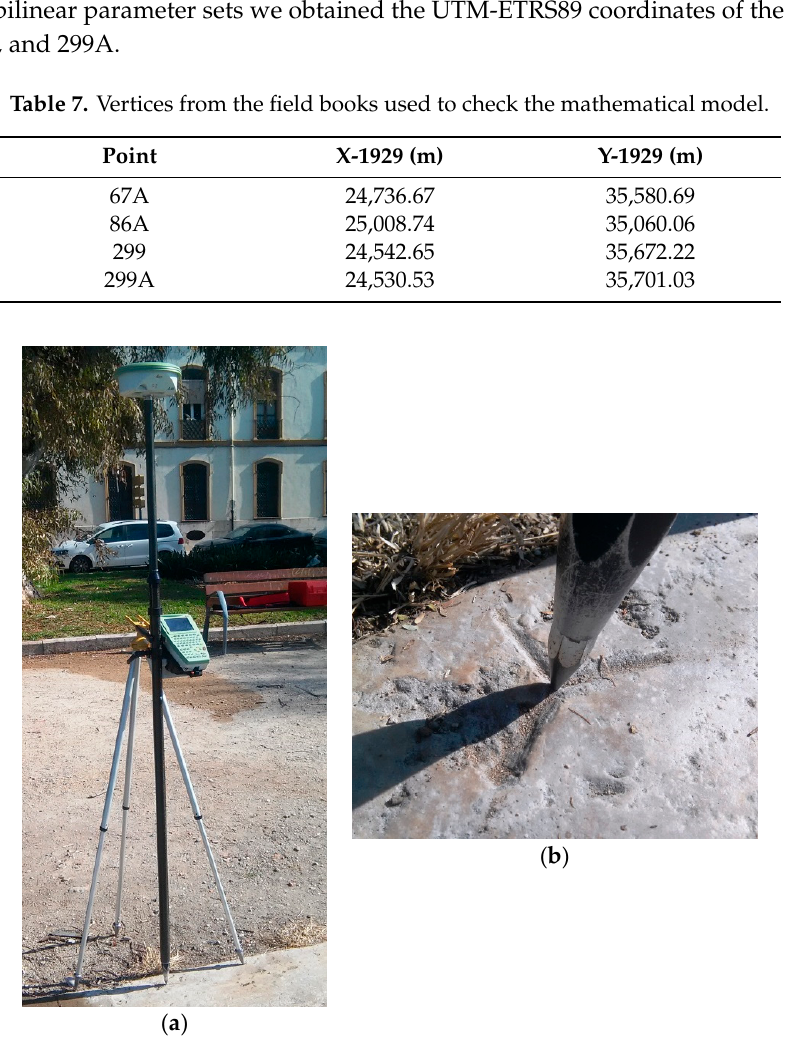
Figure 4. ( a ) The global navigation satellite system (GNSS) antenna and receptor during the resurvey of the vertex 86A; ( b ) the original mark of the vertex 86A.